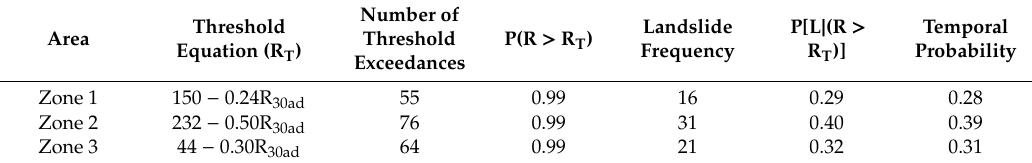
Figure 8. Annual exceedance probability (AEP) of landslide occurrences along the Samdrup Jongkhar–Trashigang Highway. Table 1. Temporal Probability of Landslide